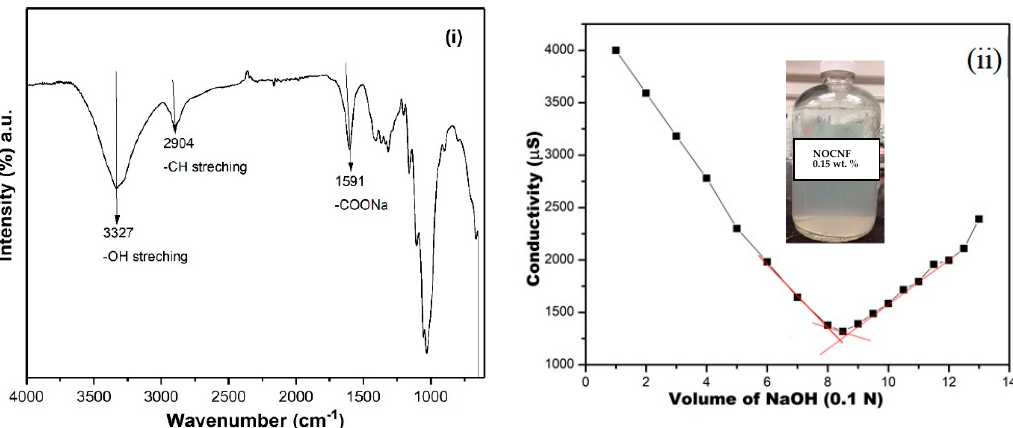
Figure 1. ( i ) Fourier transform infrared spectrometry (FTIR) of carboxycellulsoe nanofibers (NOCNF) and jute fibers, and ( ii ) conductometric titration graph to determine the carboxylate group on NOCNF (volume of NaOH consumed = 0.705 mL), inset the photograph of NOCNF suspension.